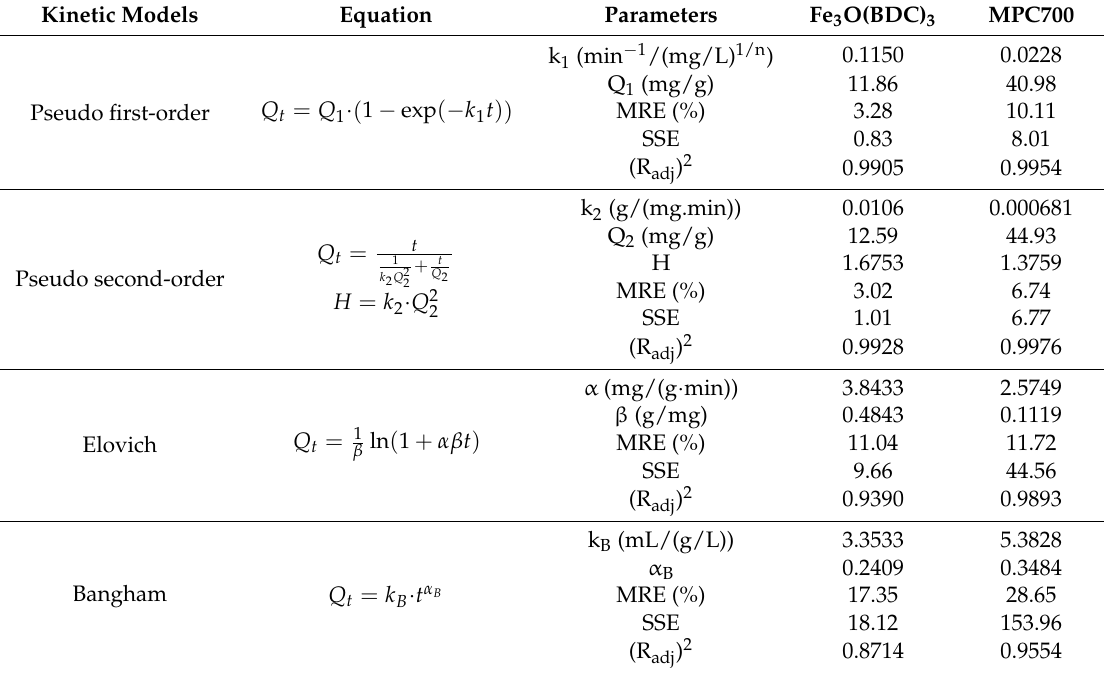
Table 4. Kinetic constants for the adsorption of CAP by Fe 3 O(BDC) 3 and